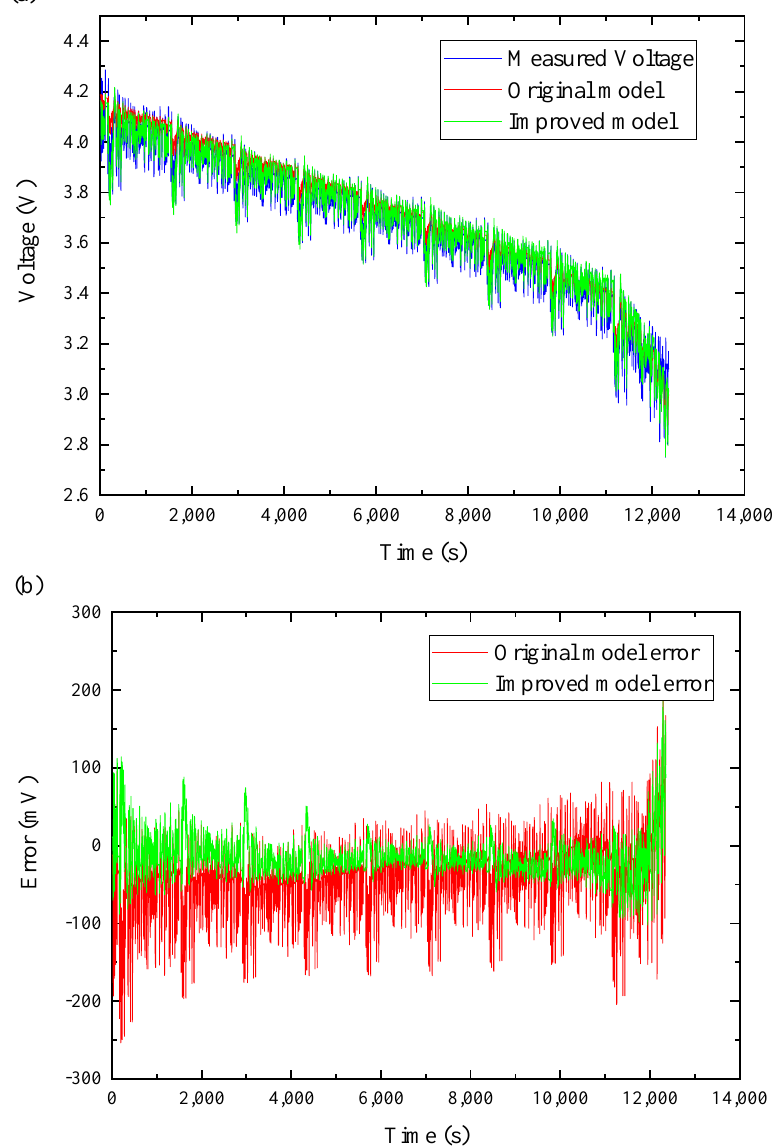
Figure 8. Comparison between measured data and model results at 0 °C: ( a ) voltage of experimental, original model and improved model; ( b ) estimated error of the original and improved model.